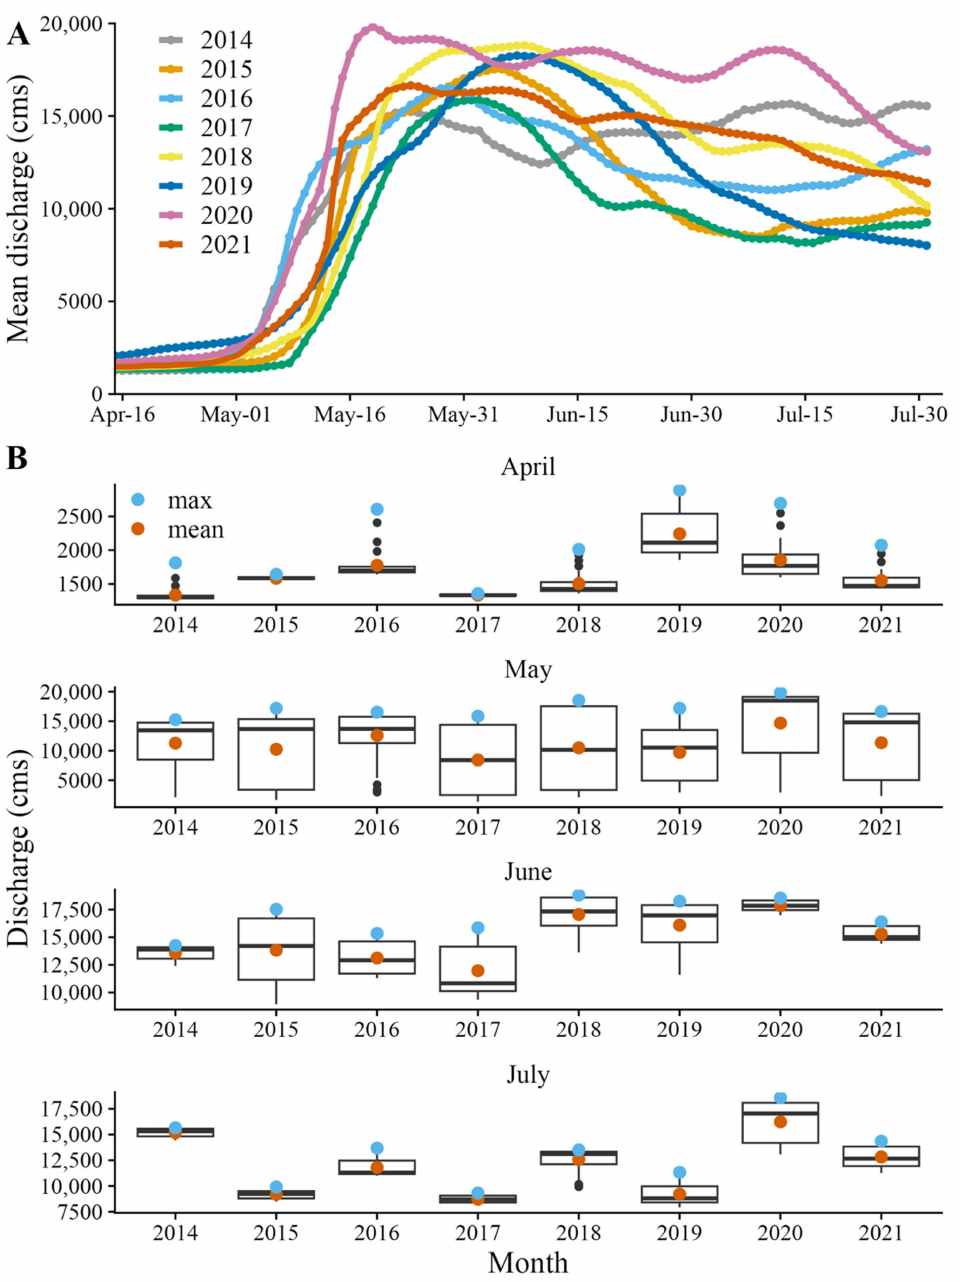
Figure 3. ( A ) Daily and ( B ) monthly discharge from the USGS gauge at Pilot Station for each sampling year and month. ( A ) Mean daily discharge by year. Discharge prior to 16 April shows the same trend, so is omitted from this figure. ( B ) Box plots of discharge by month. Bold lines represent median discharge. Blue dots represent maximum discharge and orange dots represent mean